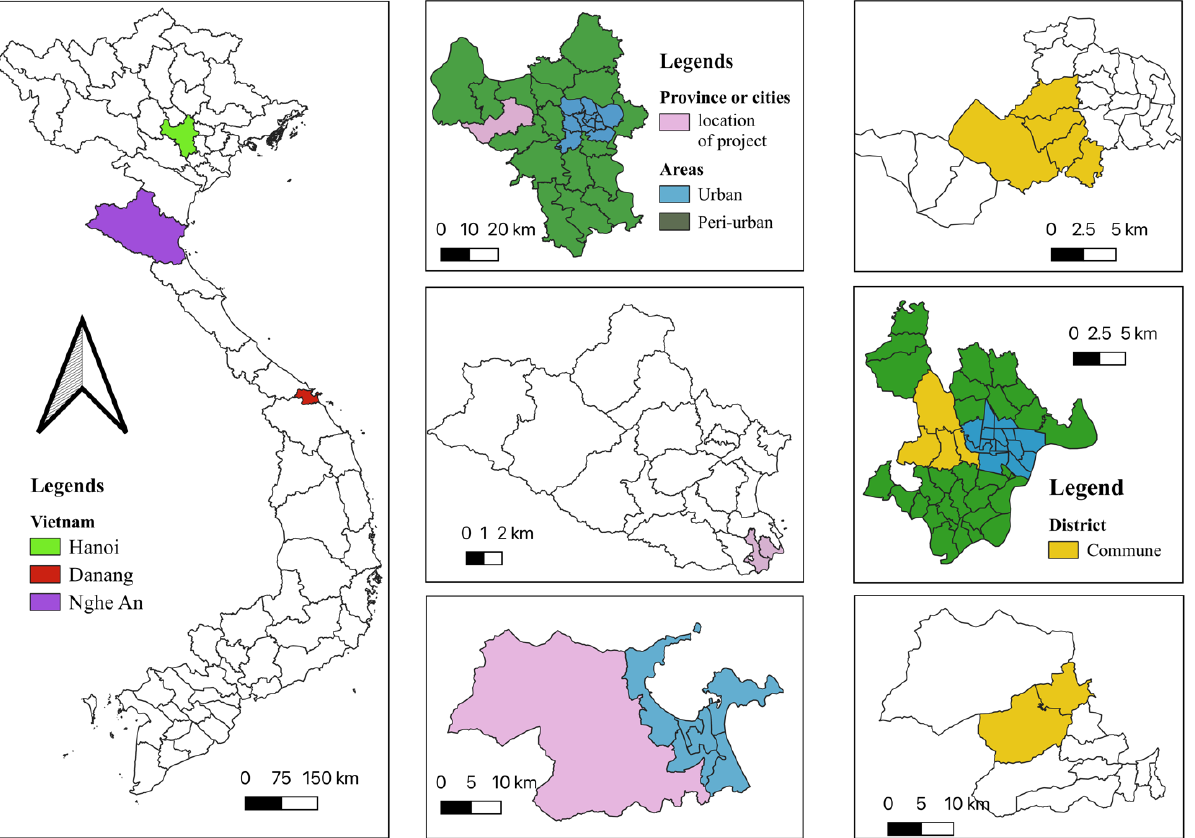
Figure 1. Geographical locations of research sites.